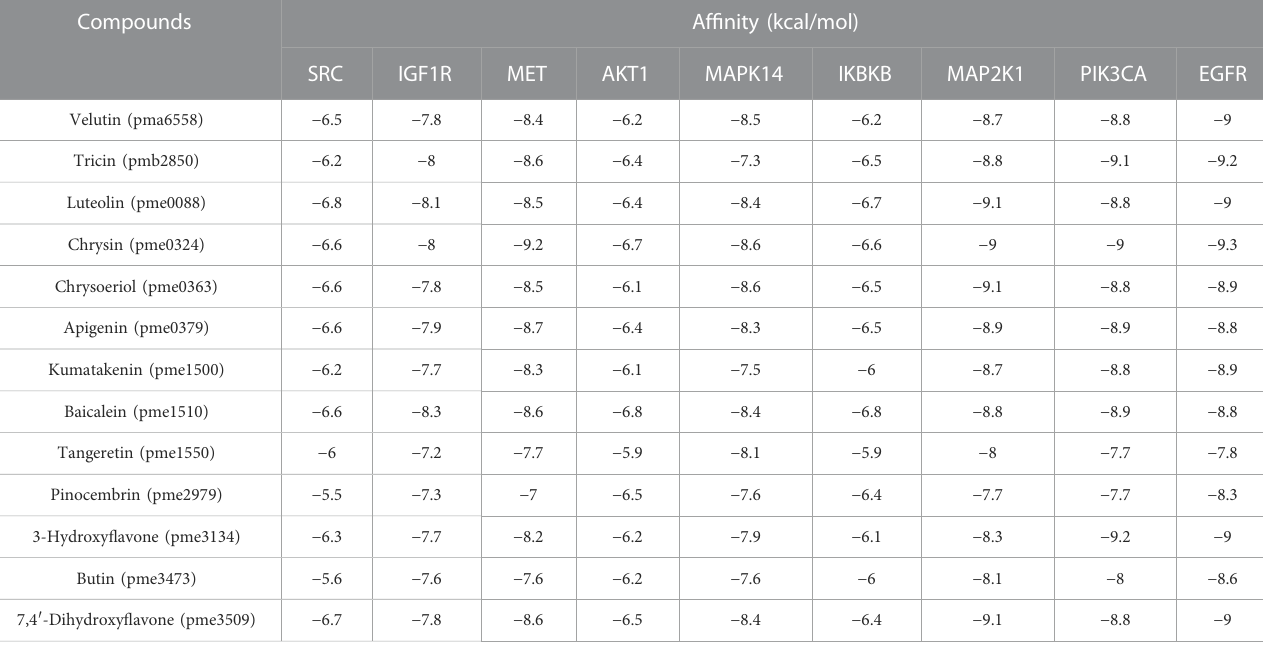
TABLE 2 Molecular docking results of potential targets with the potential active compounds of Cyclocarya paliurus.